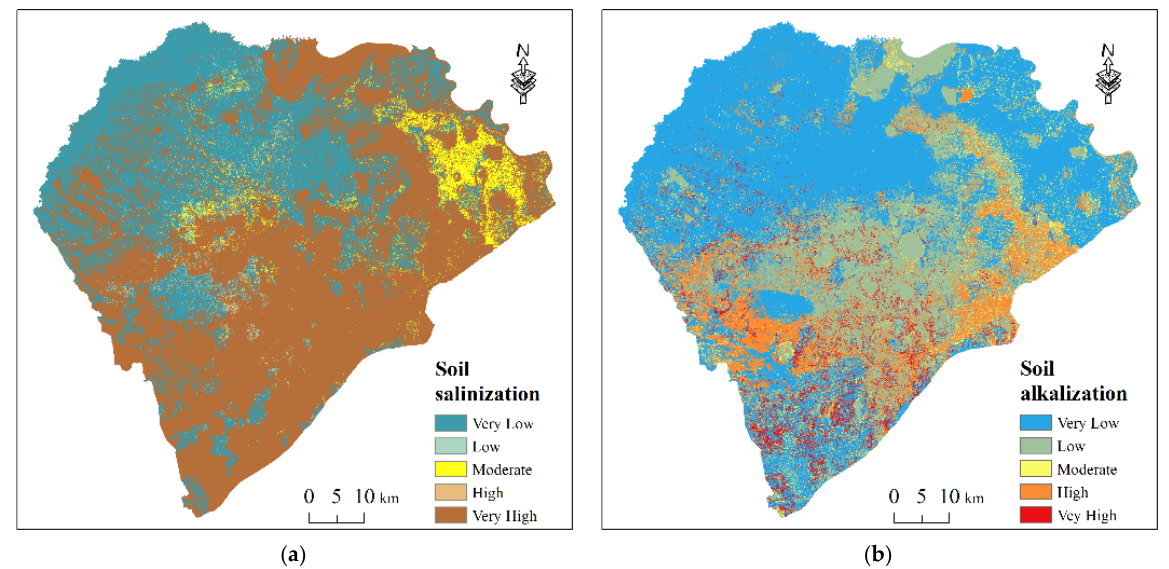
Figure 5. The spatial distribution of degrees of soil salinization ( a ) and soil alkalization ( b ) from RF–SMOTE with 16 environmental covariates.